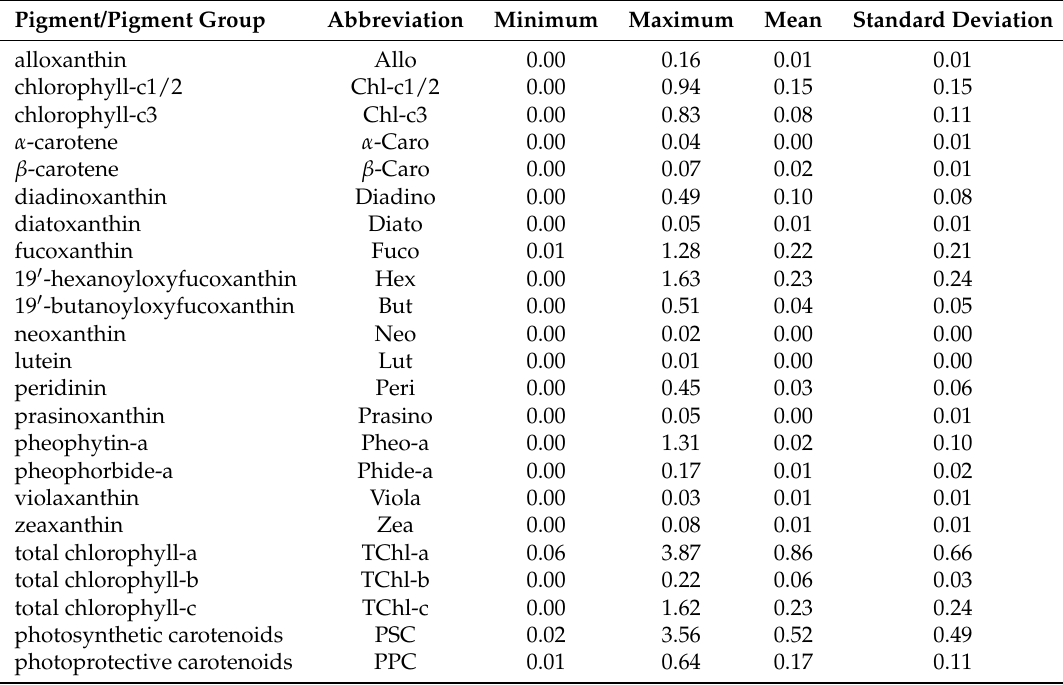
Table 1. Abbreviations of phytoplankton pigments and pigment groups analyzed in this study, and the minimum, maximum, mean and standard deviation of the pigment concentrations (mg m − 3